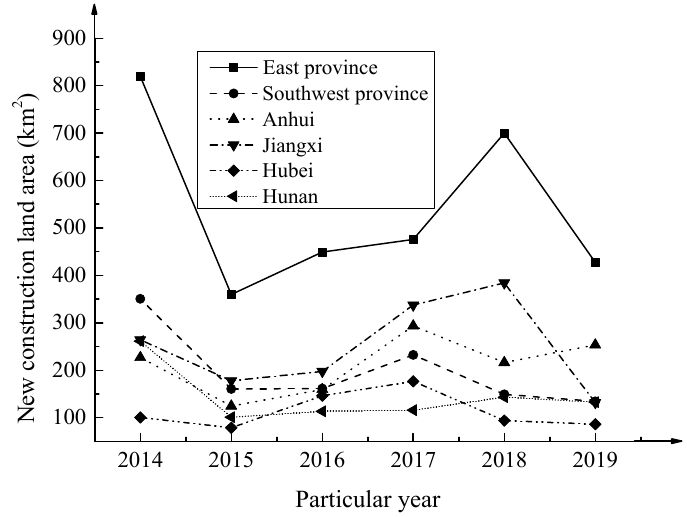
Figure 6. Changes and distribution of new urban construction land area .